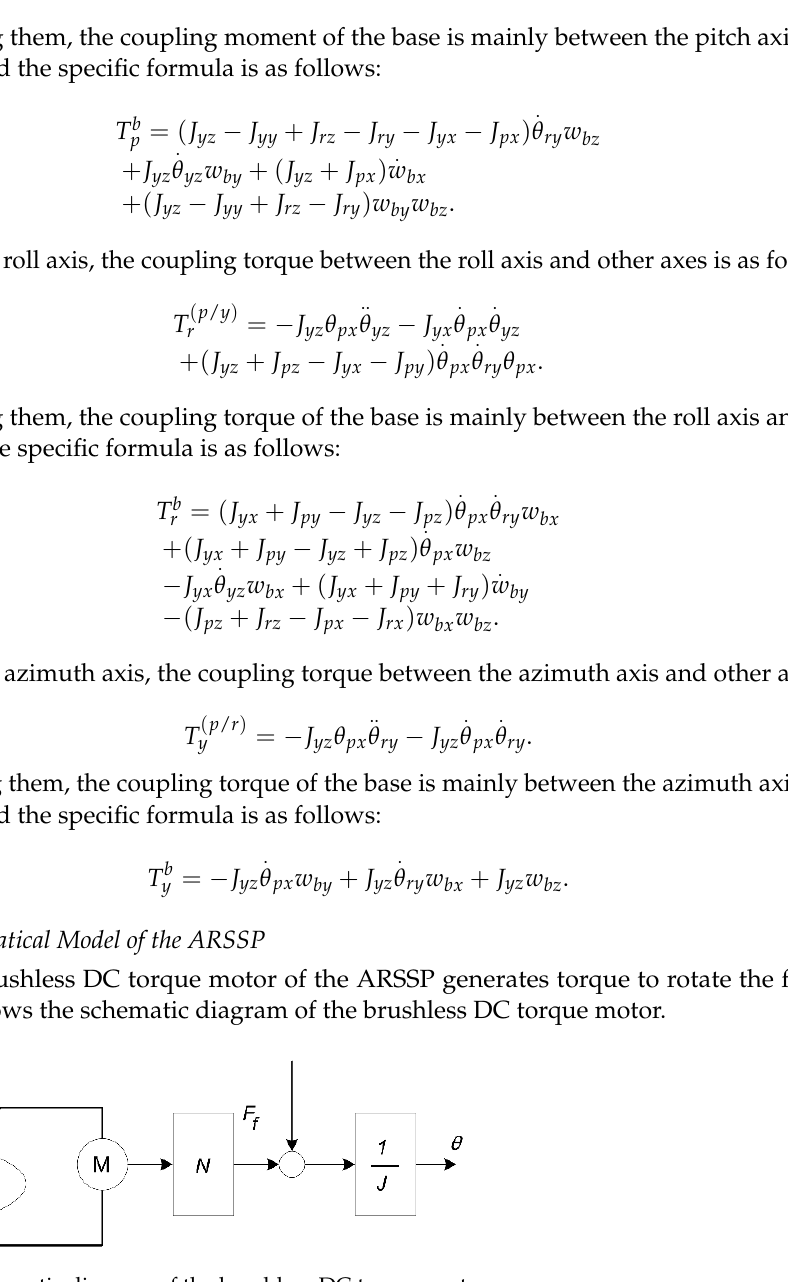
Figure 4. Schematic diagram of the brushless DC torque motor.